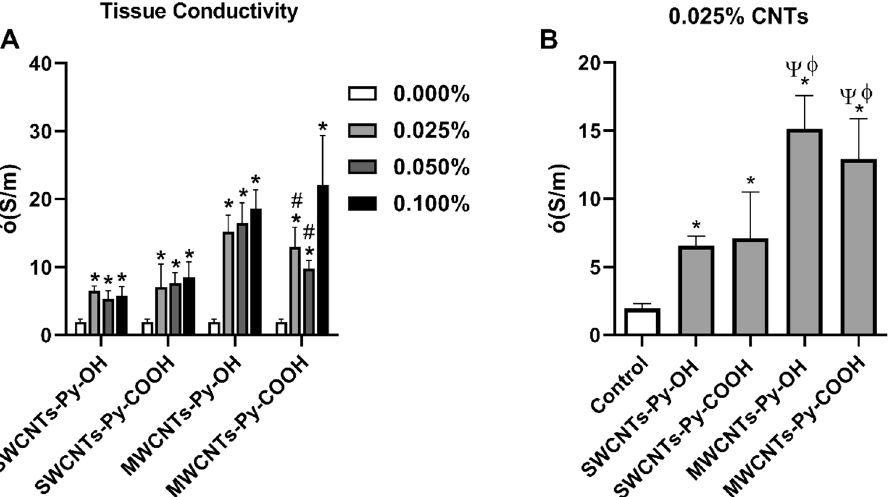
Figure 9. ( A ) Average electrical conductivity of collagen-based ECTs loaded with different concentrations of CNT test compounds. * P ≤ 0.05 compared to the control (0.000%) which contains only collagen in the matrix, # P ≤ 0.05 compared to 0.100% concentration of the test compound, ( B ) Comparison of the average electrical conductivity between the different species at 0.025% concentration of the CNTs. ψ P ≤ 0.05 compared to SWCNT-Py-OH, ϕ P ≤ 0.05 compared to SWCNT-Py-COOH as determined by one-way ANOVA test, n =